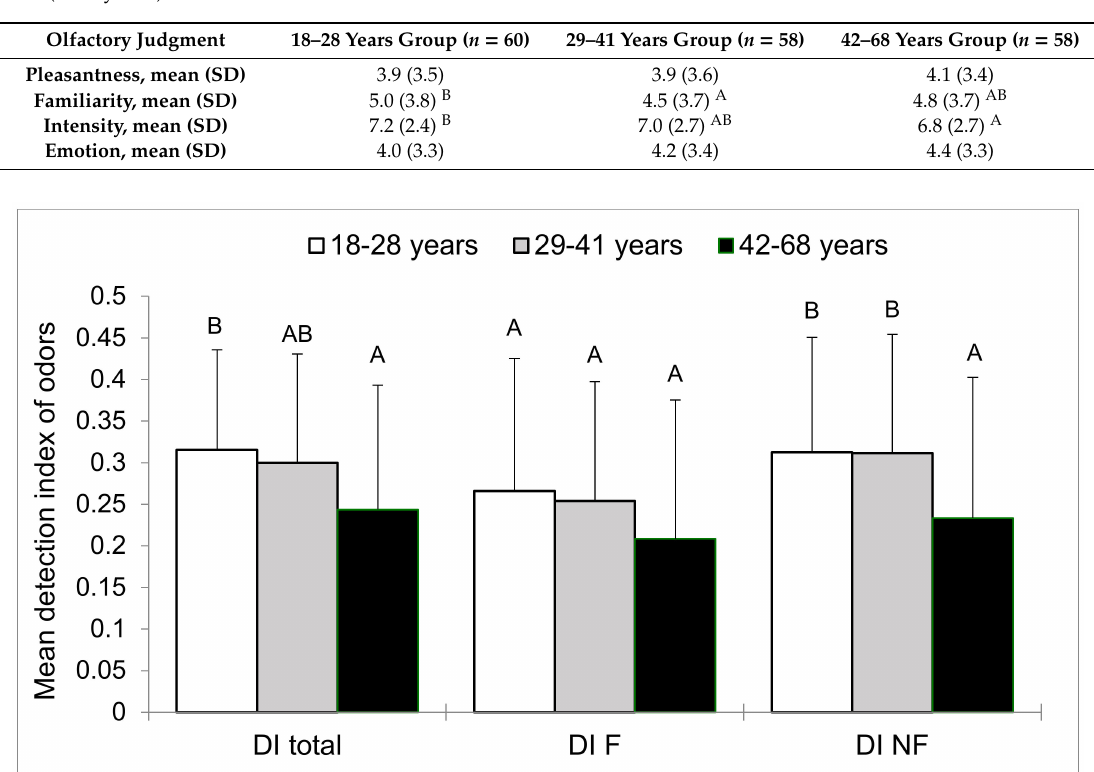
Table 3. Mean scores (standard deviation) for the olfactory judgments of all odors evaluated by the 18–28 years group, the 29–41 years group, and the 42–68 years group. For each olfactory judgment, if the means share the same letter, they are not significantly di ff erent at the 5% level of significance (Tukey test).